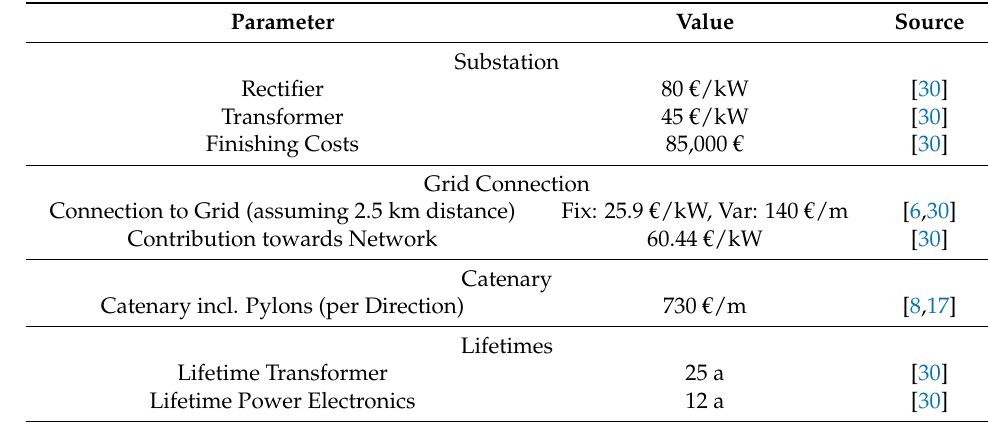
Table A3. Cost parameters for the overhead catenary infrastructure.